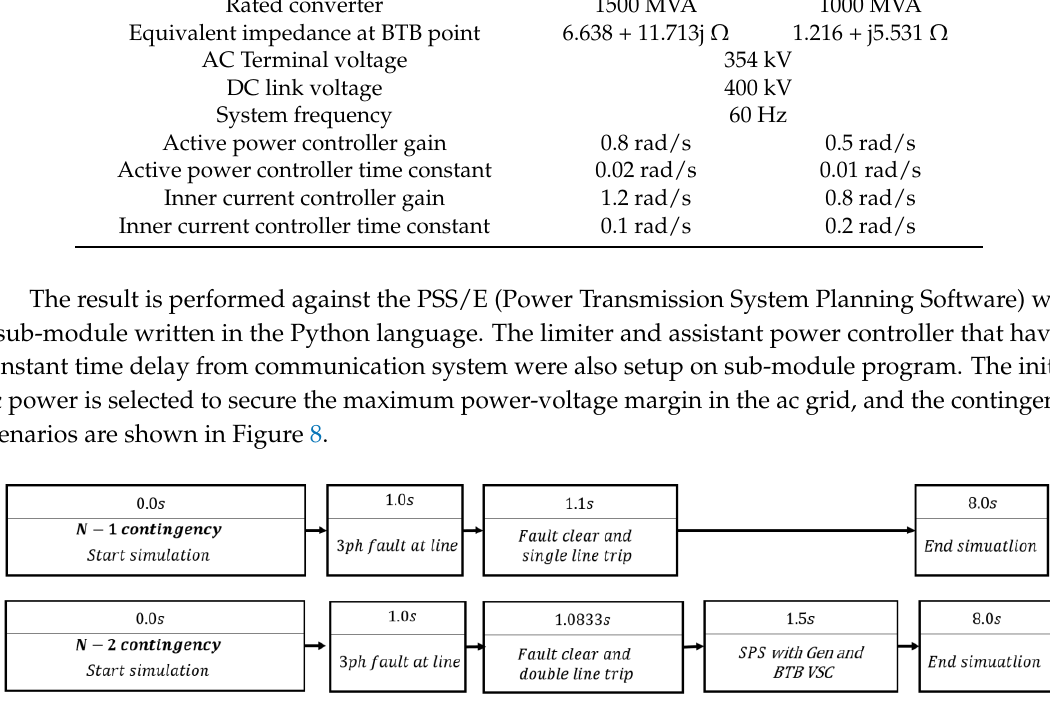
Figure 8. Contingency scenarios.